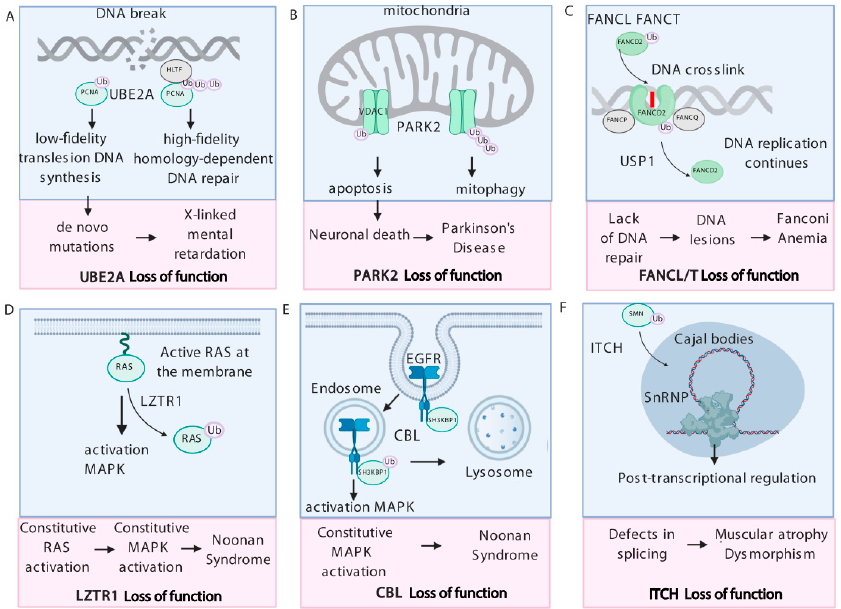
Figure 1. The role of monoubiquitination in human diseases. ( A ) Ubiquitin-conjugating enzyme E2 A (UBE2A) loss of function impairs proliferating cell nuclear antigen (PCNA)-mediated DNA repair that partiallyexplainsdevelopmentalaspectsofX-linkedmentalretardation. ( B )ParkinsonProtein2(PARK2) regulates mitophagy and apoptosis by controlling poly- and monoubiquitination of voltage-dependent anion-selective channel 1 (VDAC1). Dysregulation of VDAC1 ubiquitination contributes to the development of Parkinson’s disease. ( C ) Mutations in Fanconi Anemia complementation group L / T ( FANCL / T ) lead to DNA repair deficiency. Monoubiquitinated FA group D2 (FANCD2) / FA complementation group I (FANCI) heterodimer binds DNA, whereas deubiquitination of FANCD2 allows to re-start DNA replication. ( D ) The Rat sarcoma (RAS) GTPases are monoubiquitinated by the Leucine Zipper Like Transcription Regulator 1 (LZTR1)- Cullin 3 (CUL3) complex, inhibiting RAS association with the membrane and activating of RAS signaling. Hyperactivation of the mitogen activated protein kinase (MAPK) caused by LZTR1 loss of function leads to the Noonan syndrome phenotypes. ( E ) Casitas B-lineage lymphoma (CBL)-mediated monoubiquitination of SH3 domain-containing kinase-binding protein 1 (SH3KBP1) recruits active epidermal growth factor receptor (EGFR) for degradation. CBL mutations lead to up-regulation of the MAPK pathway that partially explains its contribution to the development of Noonan syndrome. ( F ) Mutations in E3 ubiquitin-protein ligase Itchy ( ITCH ) impair the monoubiquitination of survival motor neuron (SMN) that dysregulates translocation to Cajal bodies and a ff ects post-transcriptional regulation of gene expression, linking ITCH loss of function to the development of spinal muscular